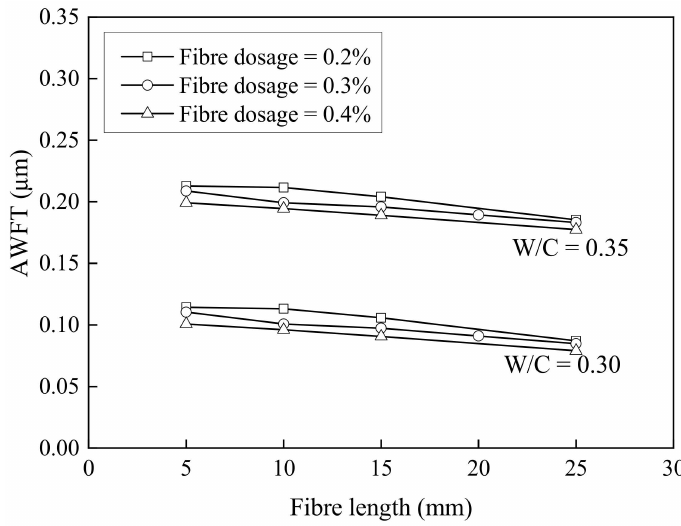
Figure 3. AWFT versus basalt fibre length for different fibre